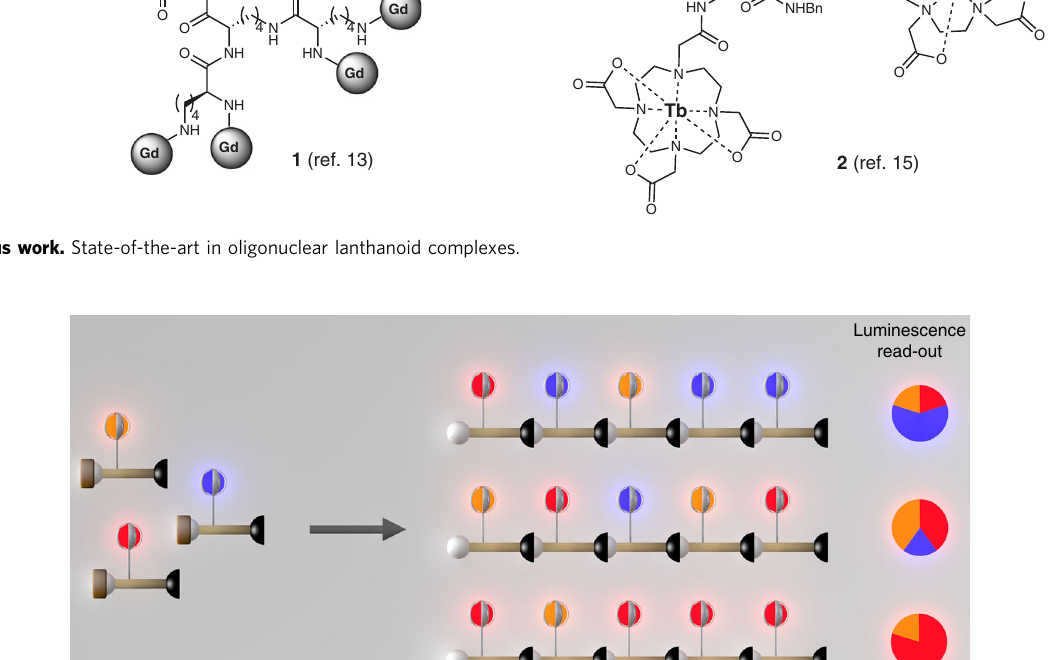
Fig. 2 Lanthanoid complexes. Schematic representation of sequence-speci fi c, heterooligonuclear lanthanoid complexes — molecular luminescence